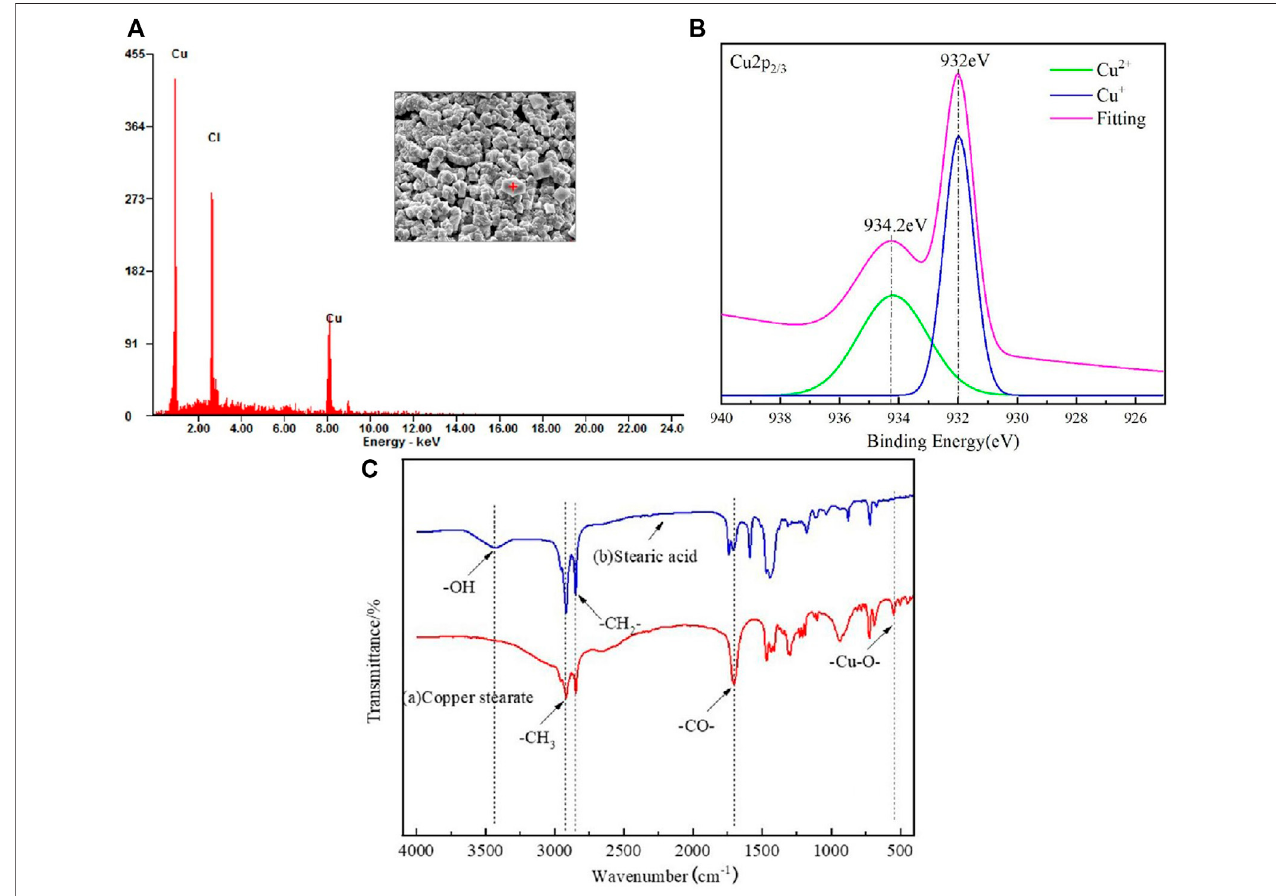
FIGURE 4 | (A) EDS spectrum of the FeCl 3 treated copper mesh surface. (B) XPS of the FeCl 3 treated copper mesh surface. (C) FTIR spectra of SA and copper stearate.